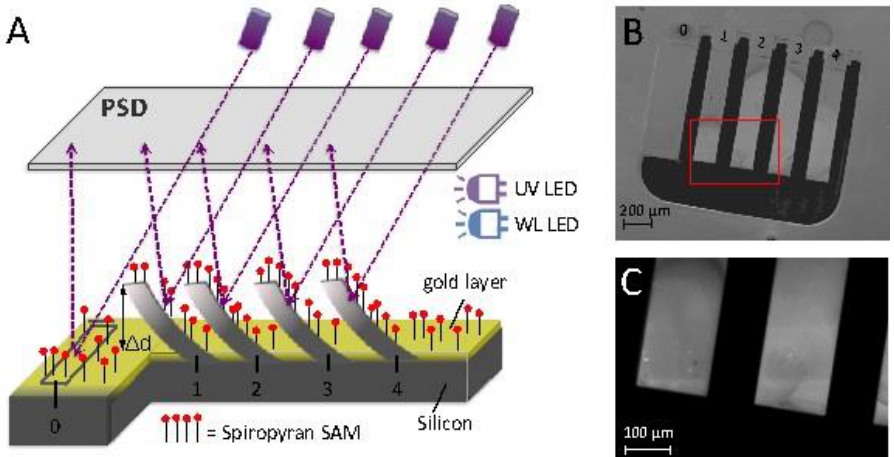
Figure 2. ( A ) Schematic representation of the optical deflection detection method (based on a VCSEL array as the light source and a position-sensitive device (PSD) as detector) for one well of the array comprising of: 0-reference mirror; 1–4-SP self-assembled monolayer (SAM) functionalized microcantilevers; The UV LED and white light (WL) LED used for the SP / MC switching are also shown. ( B ) SEM image of one individual well composed of 4 microcantilevers and one reference mirror; ( C ) SEM detail of